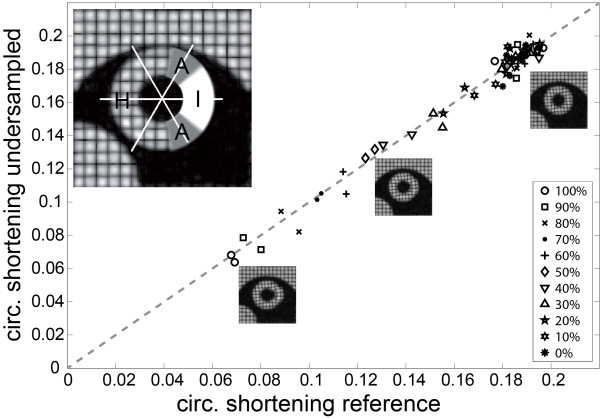
Comparison of peak circumferential shortening from undersampled (R = 3) and fully sampled simulated data. Myocardium was divided into three groups: infarction (I), which covers a sector of 80° (22% of myocardium), healthy tissue (H) and infarct adjacent (A) tissue “attaching” infarcted to healthy tissue over a sector of 40° (11% of myocardium). For infarcted tissue, different degrees of immobilized tissue ranging from 0% to 100% were simulated. The dashed line indicates the reference diagonal with slope 1.